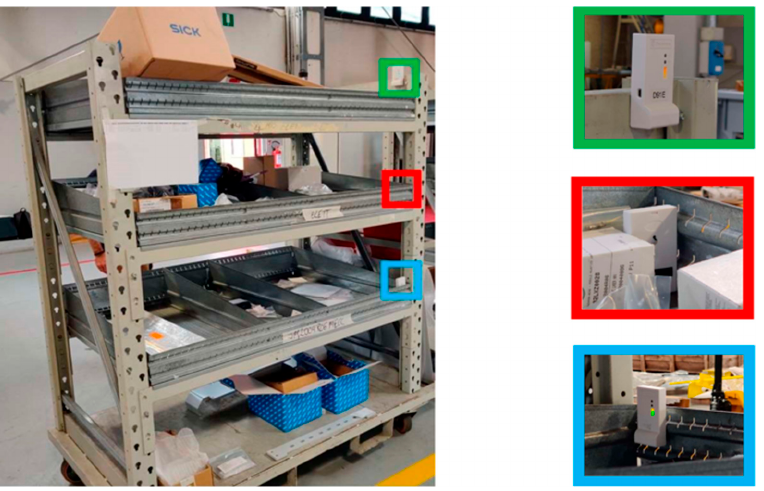
Figure 23. Different positions of the tag in Test 6: High-Tag (green), Mid-Tag (red) and Low-Tag (blue).